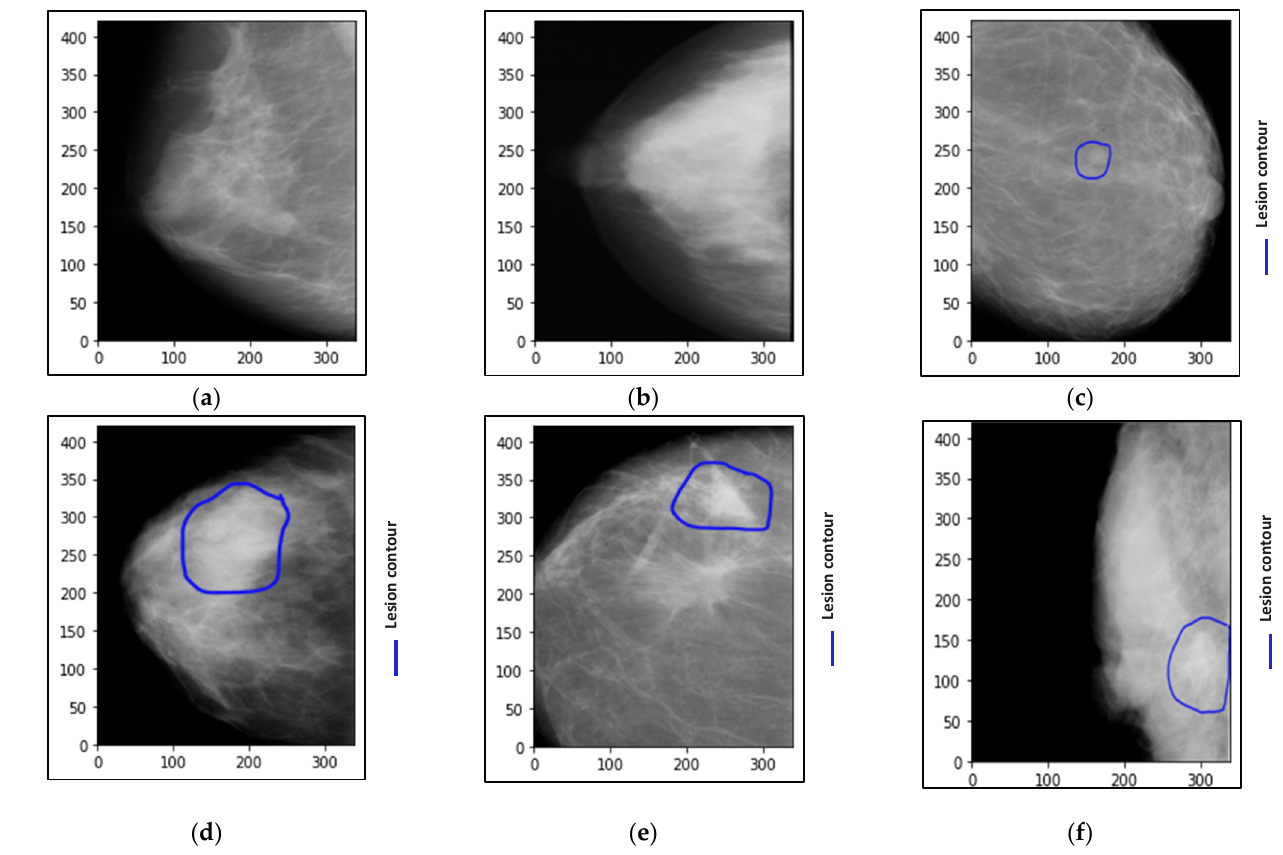
Figure 1. Examples of breast cancer mammograms with the abnormality localization as a blue contour around the breast lesions. ( a , b ) are normal cases, ( c , d ) are benign cases, and ( e , f ) are malignant cases.